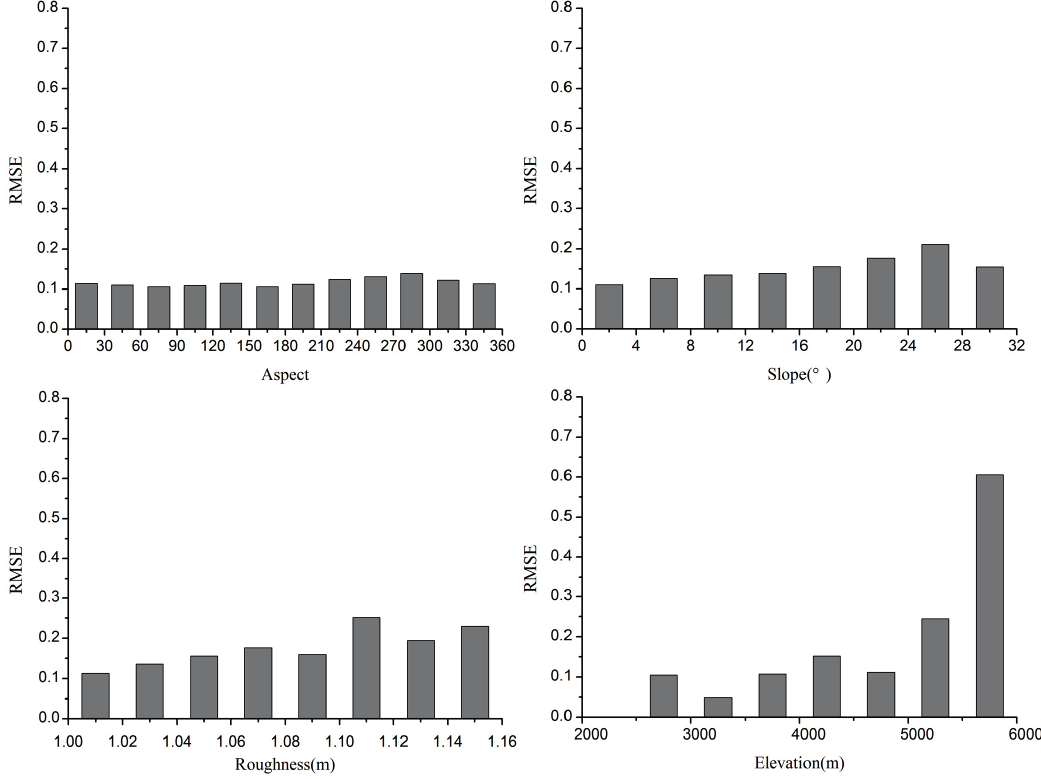
Figure 11. RMSE as a function of aspect, slope, roughness and elevation in alpine